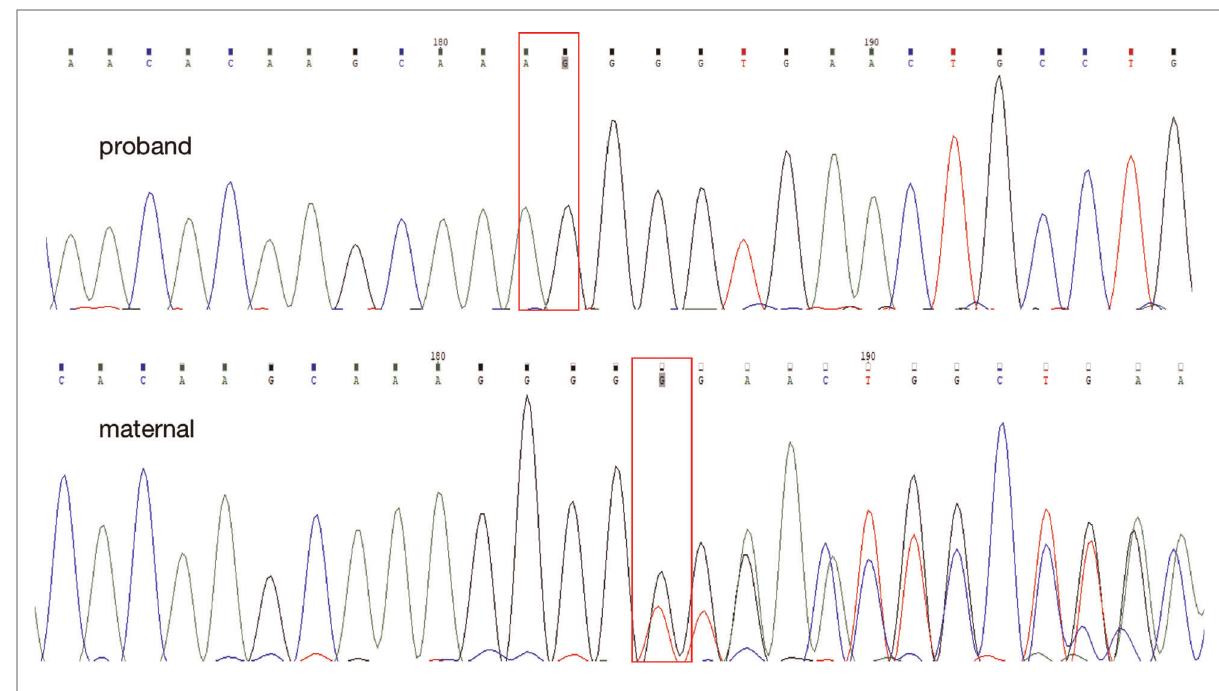
FIGURE 3 The direct DNA sequencing of the proband and his mother. The red box identi fi ed the novel delete mutation (c.1448delG), leading to a single amino acid change at amino acid 483 and to a truncated ClC-5